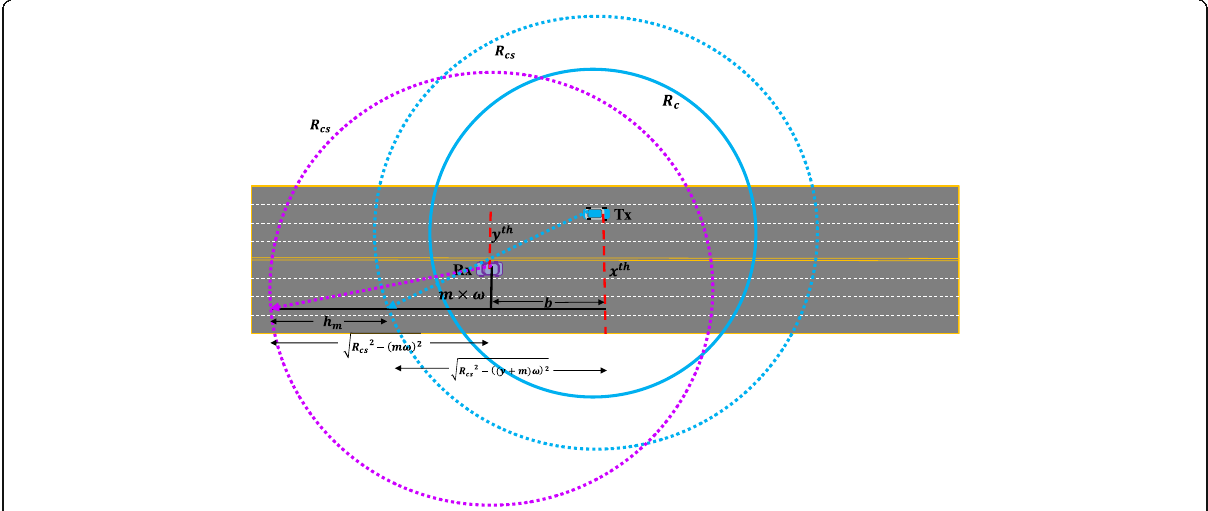
Fig. 22 The average number of hidden terminal nodes calculation for the transmitter-receiver